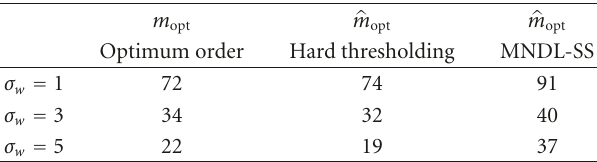
Table 1: Comparing m opt and its estimates using MNDL hard thresholding and MNDL-SS methods for the Blocks